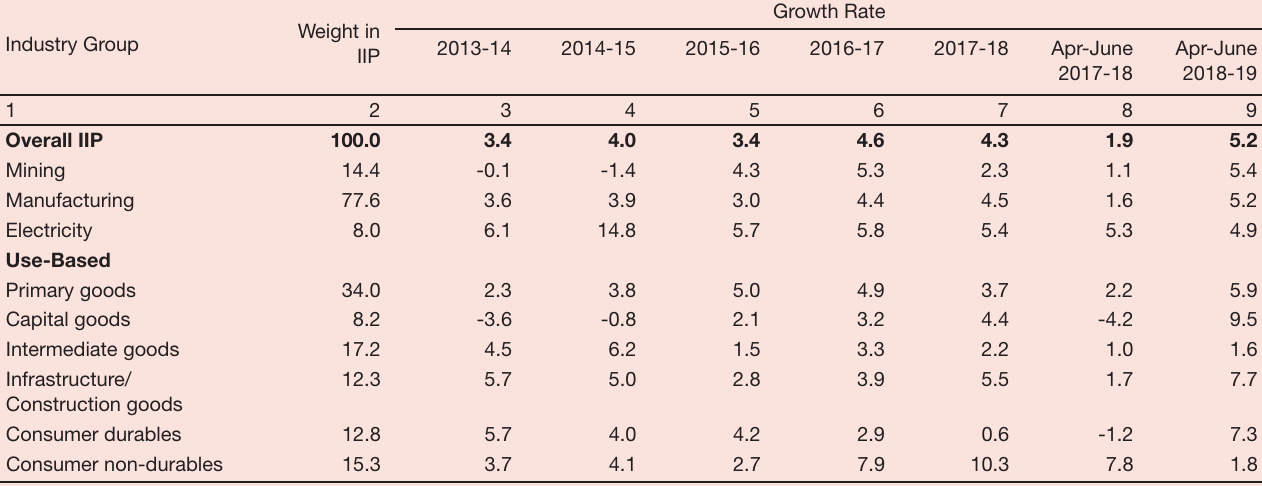
Table II.1.4: Index of Industrial Production (Base